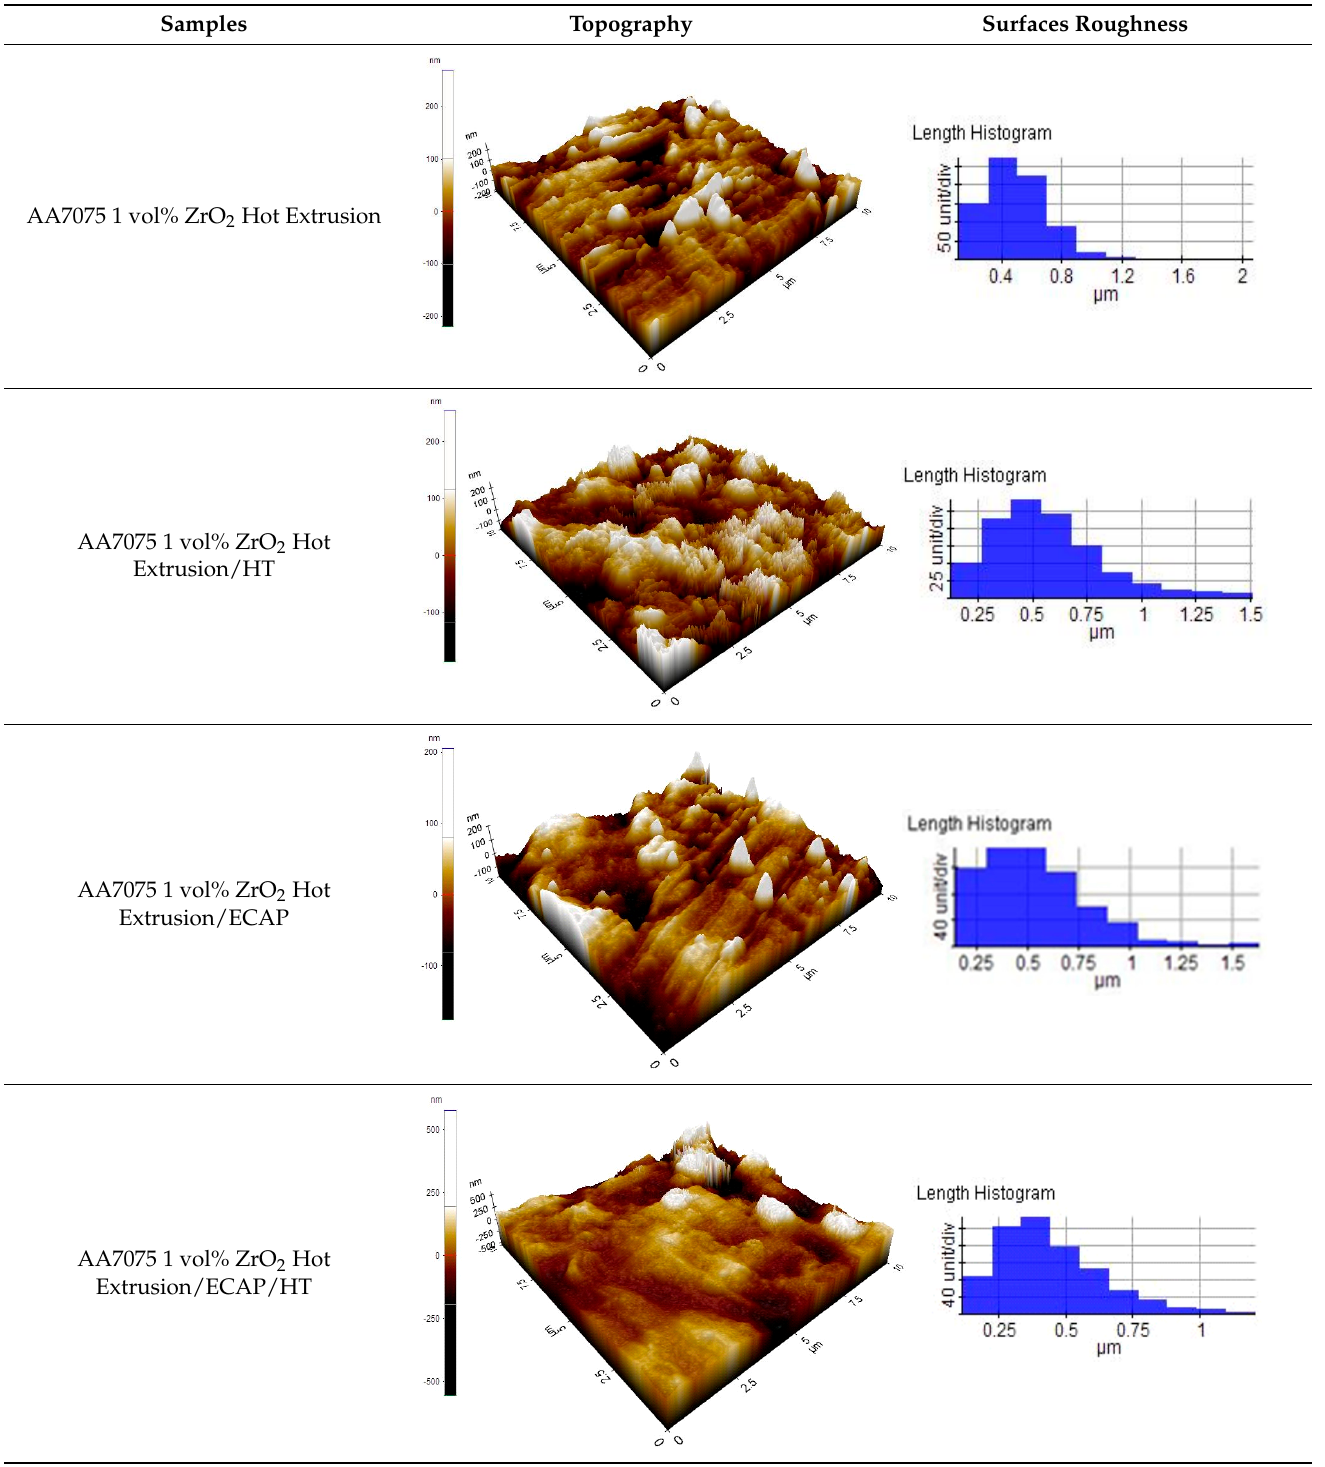
Table 12. AFM mean grain size and surfaces roughness.